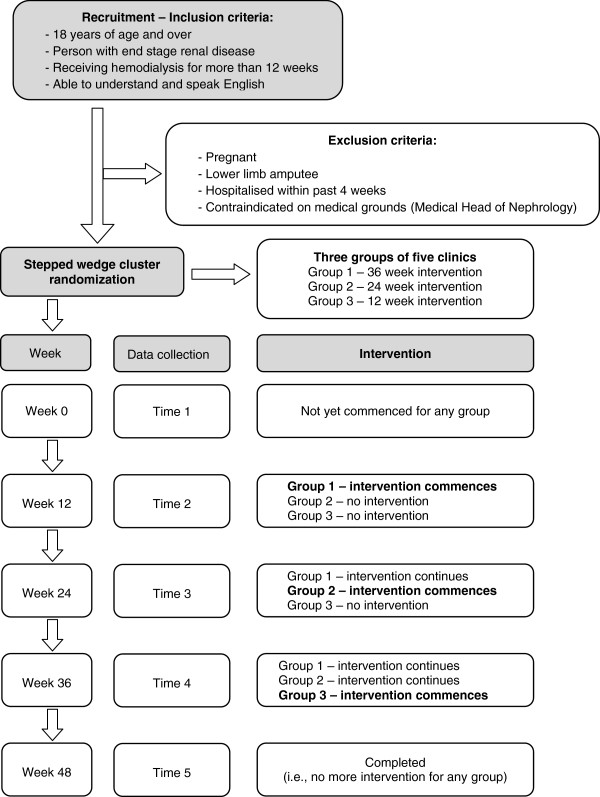
Flow chart of trial.